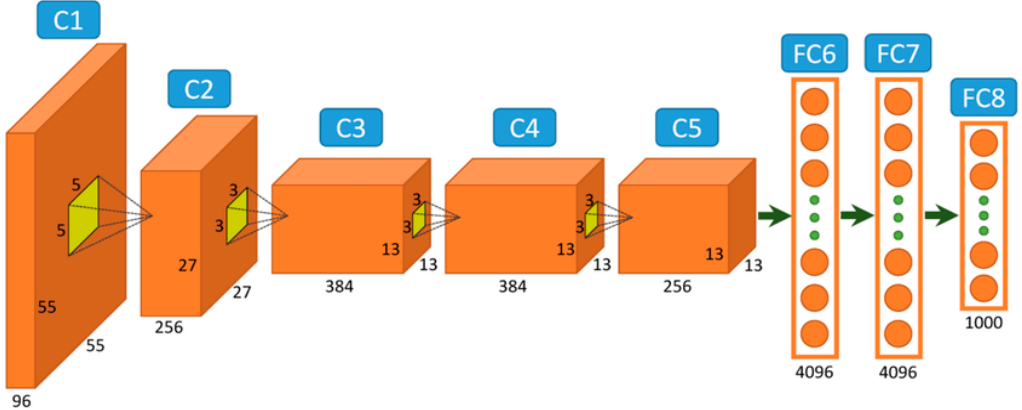
Figure 6. A Convolutional Neural Network (CNN) architecture.